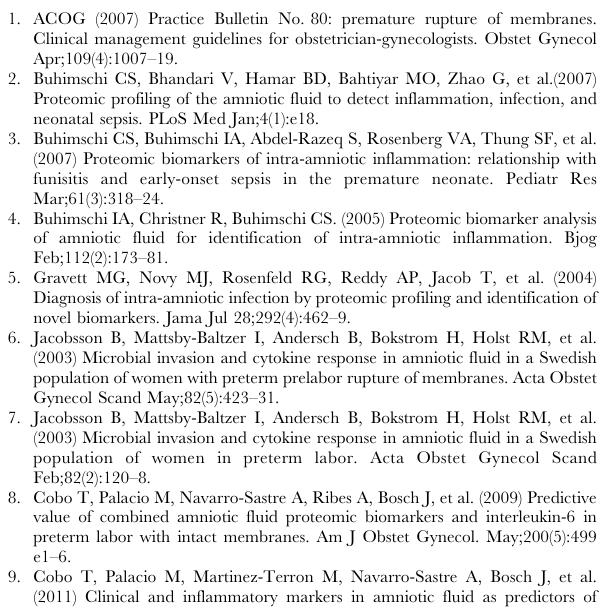
Table S1 Comparison of the levels of proteins (pg/mL) from the maternal serum compartment in women with or without